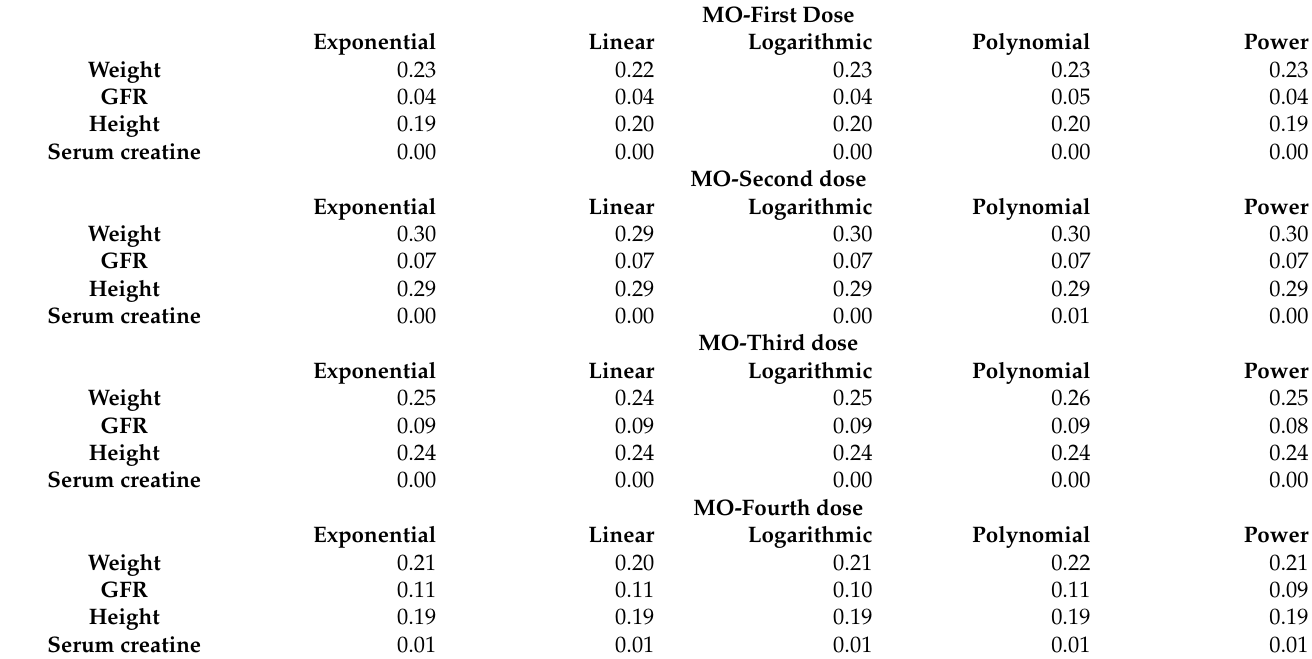
Table 3. The reported R 2 value from the five different regression models for the parameters of the morbidly obesity (MO) population and the drug peak concentration after each dosing. MO-First